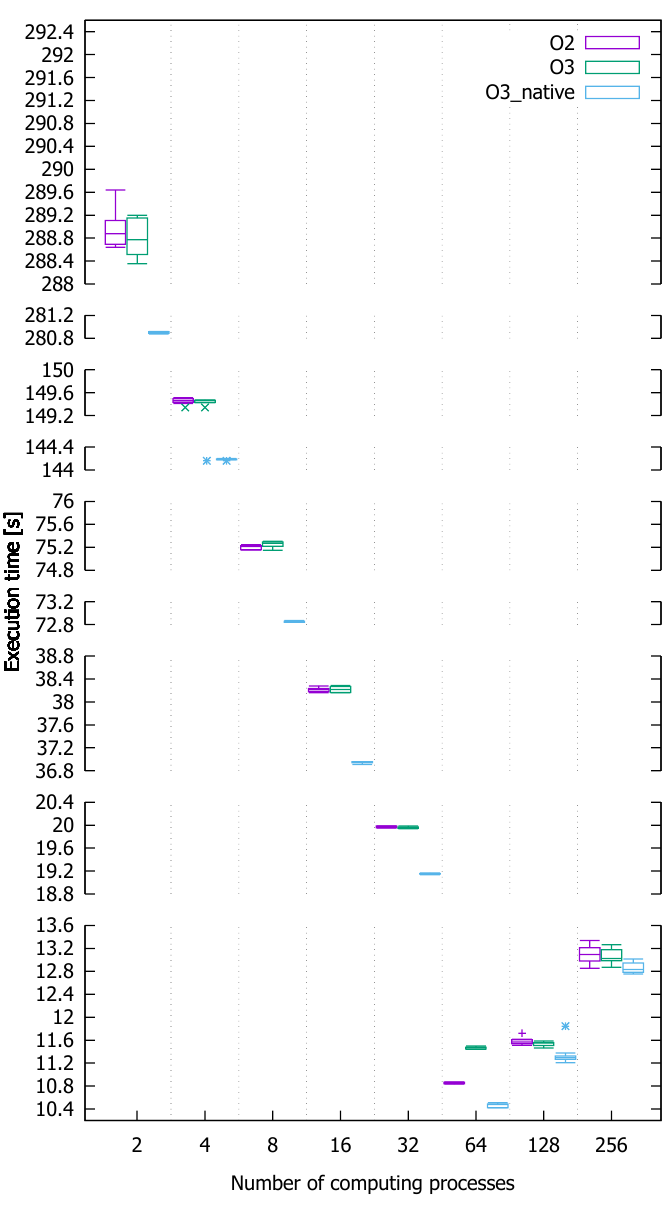
Figure 11. Execution times for MasterSlave, for better of Docker and host versions; boxplot nota- tion: medians, Q1 and Q3, max(Q1 − 1.5IQR, minimum) and min(Q3+1.5IQR, maximum) as well as potential outliers (+ for O2, x for O3, * for